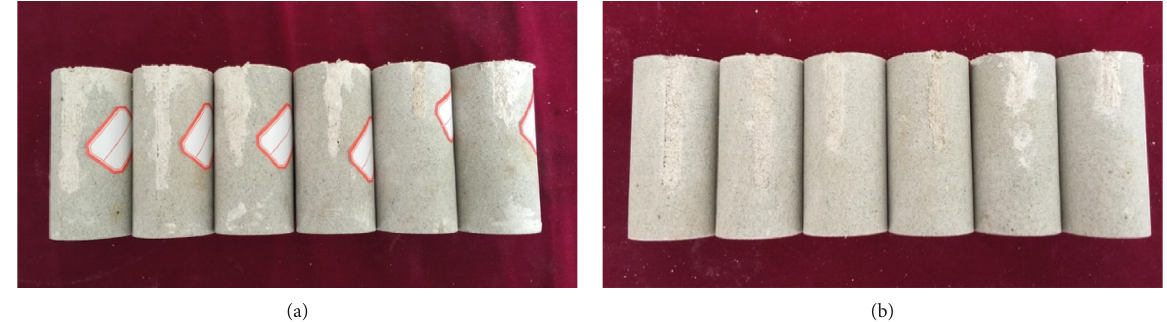
Figure 4: Cracked rocks filled with (a) gypsum mortar and (b) cement mortar.